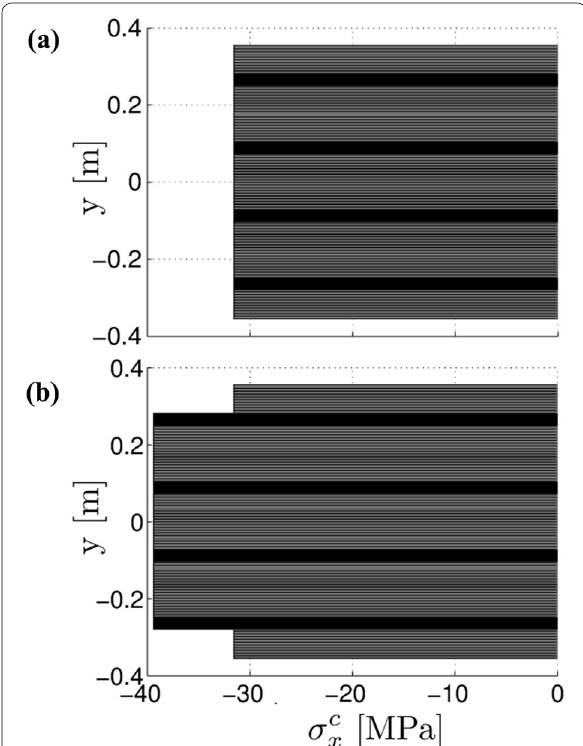
Fig. 8 Reaction force vs. displacement curves of the column compression with the concrete ultimate strain being function of the hydrostatic